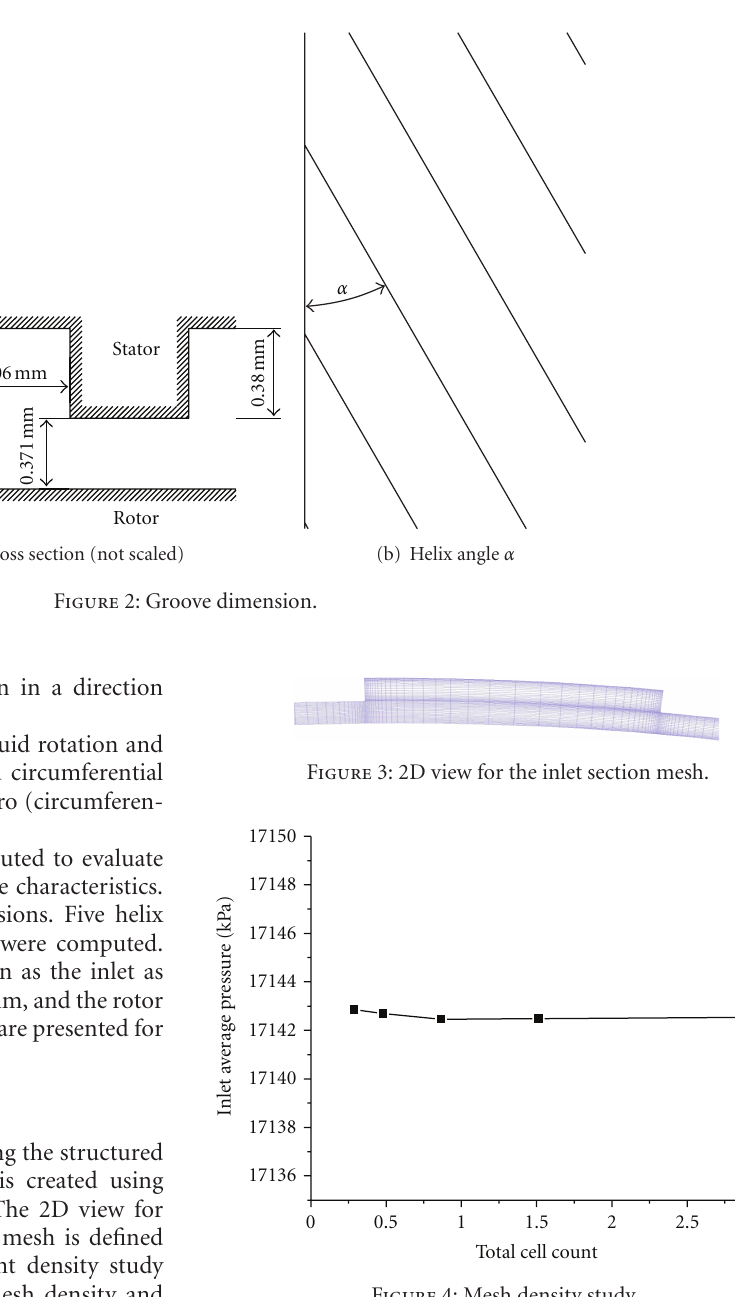
Figure 4: Mesh density